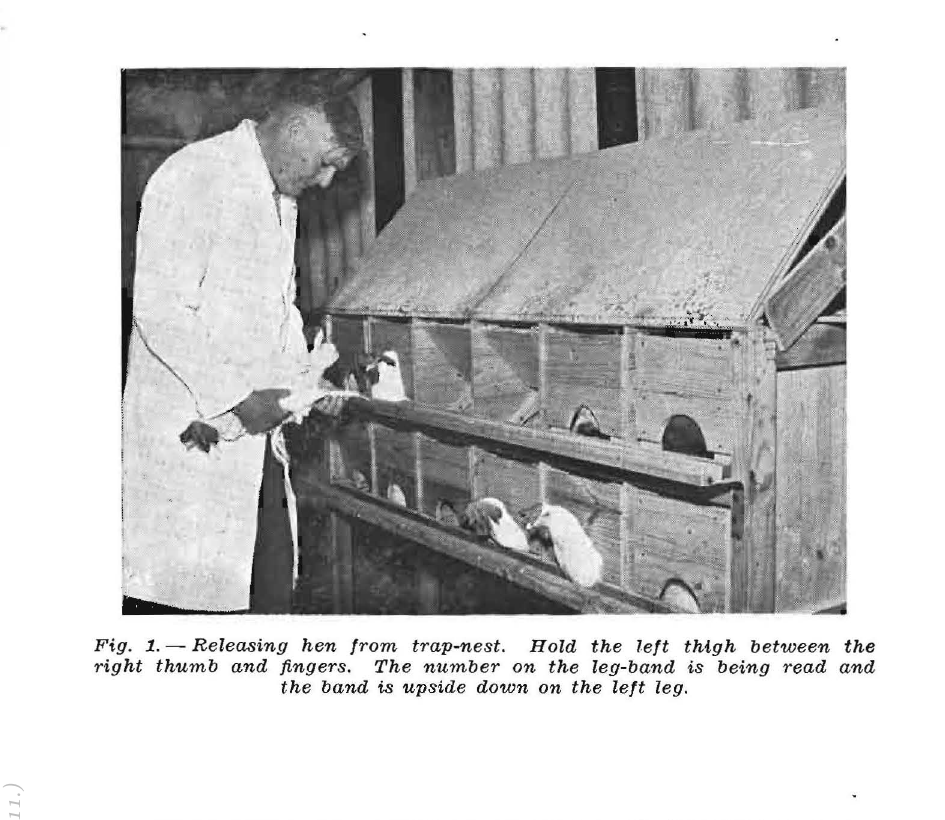
Fig. 1. - ReleMing hen from trap-nest. Hold the left thigh between the right thumb and fingers. The number on the leg-band is being read and the band is upside down on the left leg.